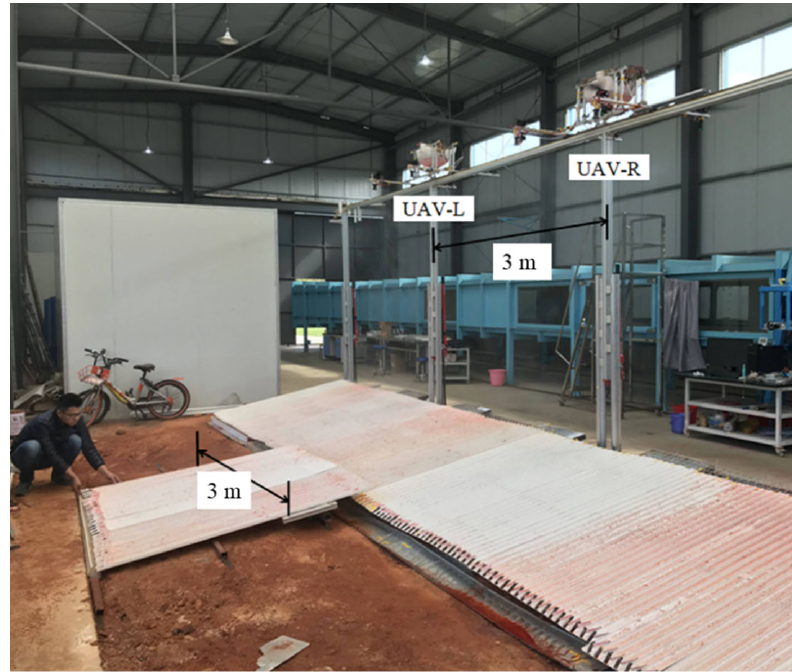
Figure 9. Illustration of droplet collection area.